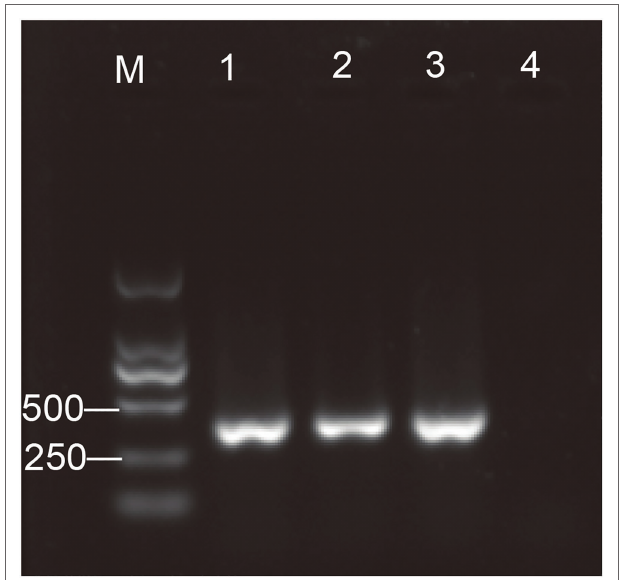
FIGURE 1 | Detection of the antelope torovirus (AToV) by semi-nested RT-PCR. One percent of agarose gel electrophoresis. Lanes: M, Marker, DL2000; 1–3, AToV-positive fecal samples; and 4, negative control. Specific amplicon for the antelope torovirus (AToV) corresponds to a size of 390